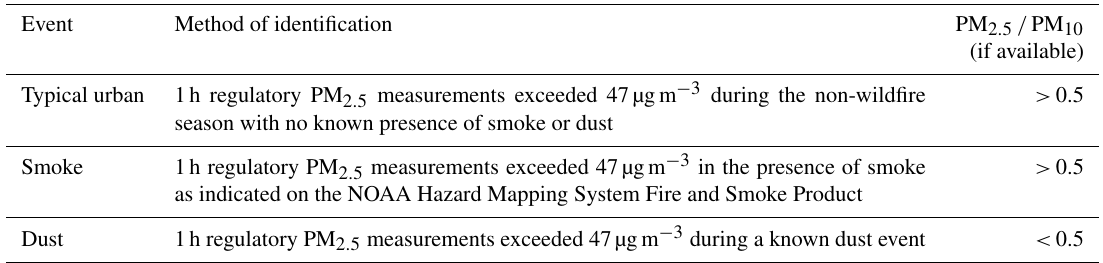
Table 1. Methodology for identification of pollution events for 50 cases in Part I.